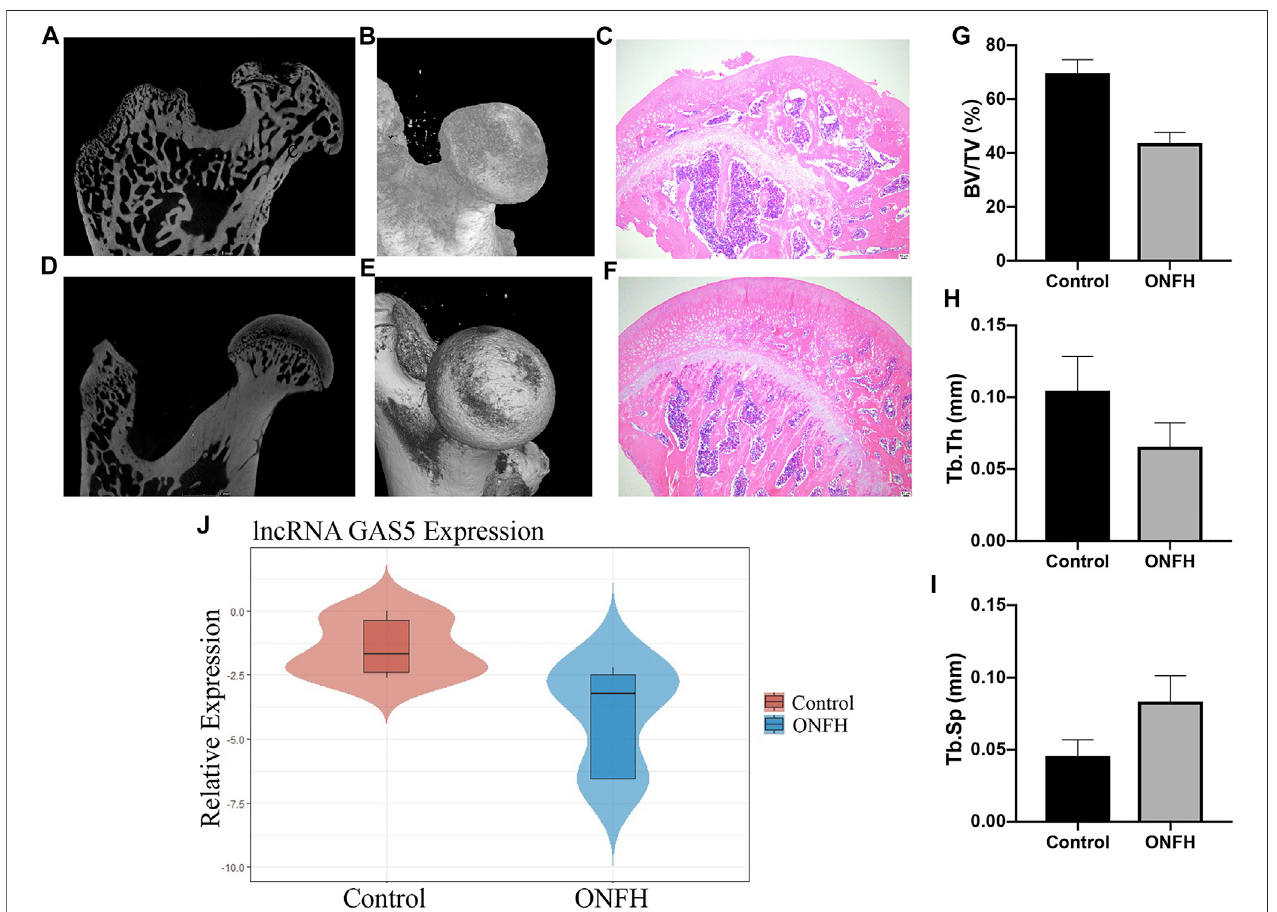
FIGURE 4 | lncRNA GAS5 expression level in ONFH rat model. (A – F) Micro-CT and hematoxylin – eosin staining images of femoral head of rat models in the ONFH group and healthy control group. (G – I) The BV/TV (%), Tb.Th (mm) values, and Tb.Sp (mm) values of rat femoral heads. (J) lncRNA GAS5 expression level in ONFH rat models compared to healthy control